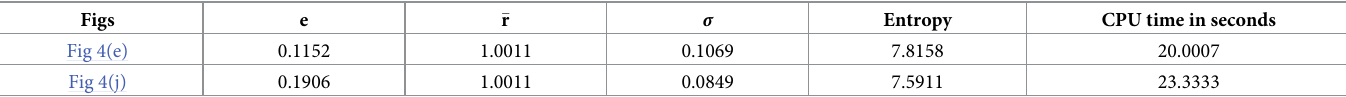
Table 3. Quantitative results of the model-M3 under e, � r , σ , entropy measure and CPU time for the de-hazed images of realistic CCTV camera captured images under heterogeneous haze.